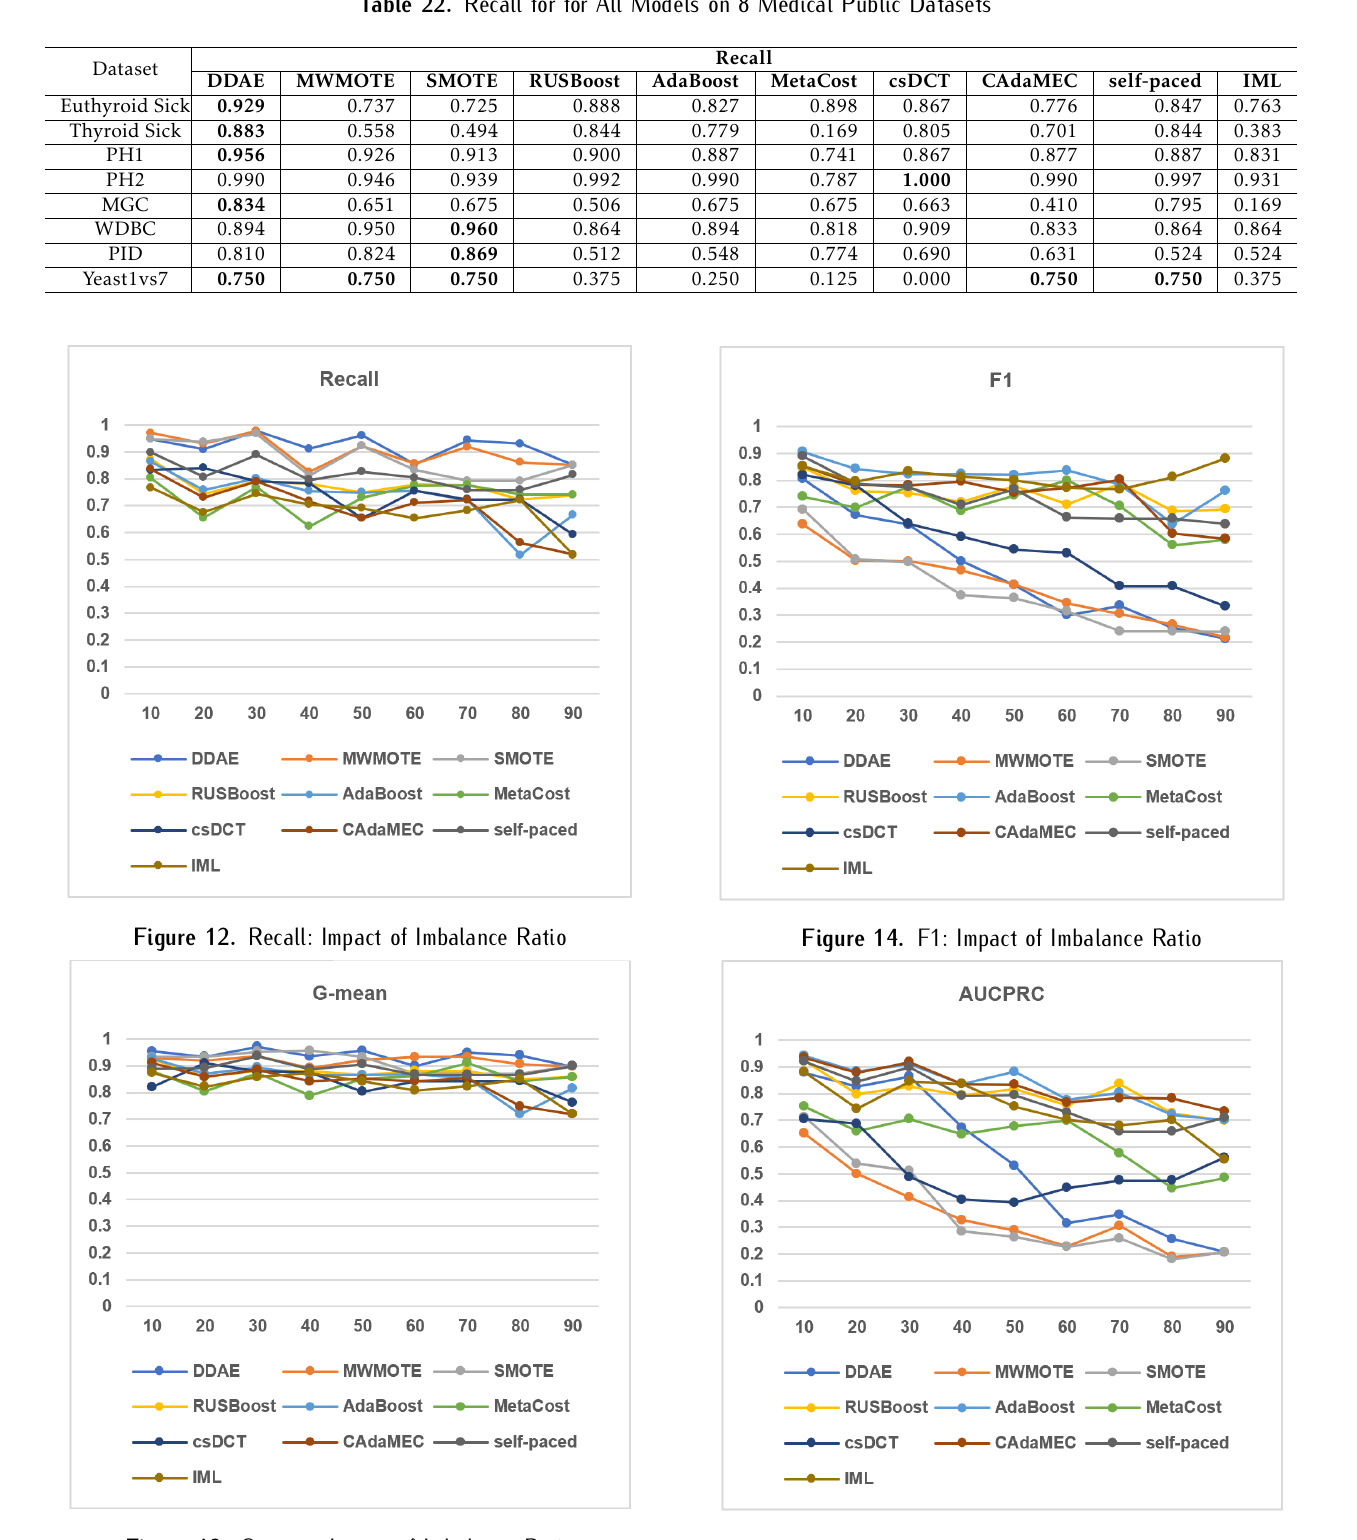
trend of recall for a specific model maintains stability